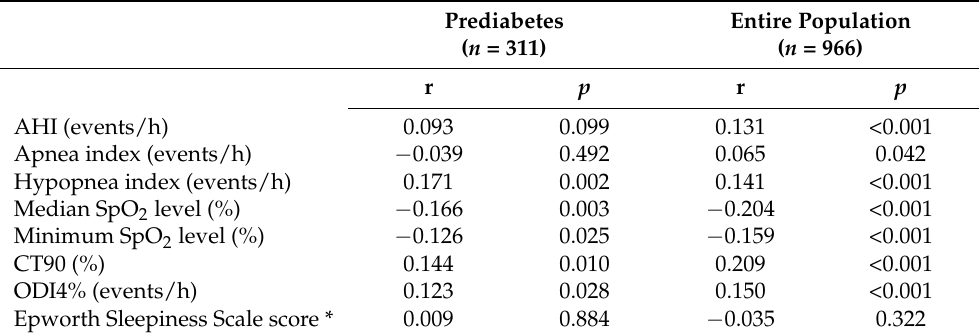
Table 3. Correlations of sleep respiratory measurements with glycated hemoglobin in the entire population and in participants with prediabetes.